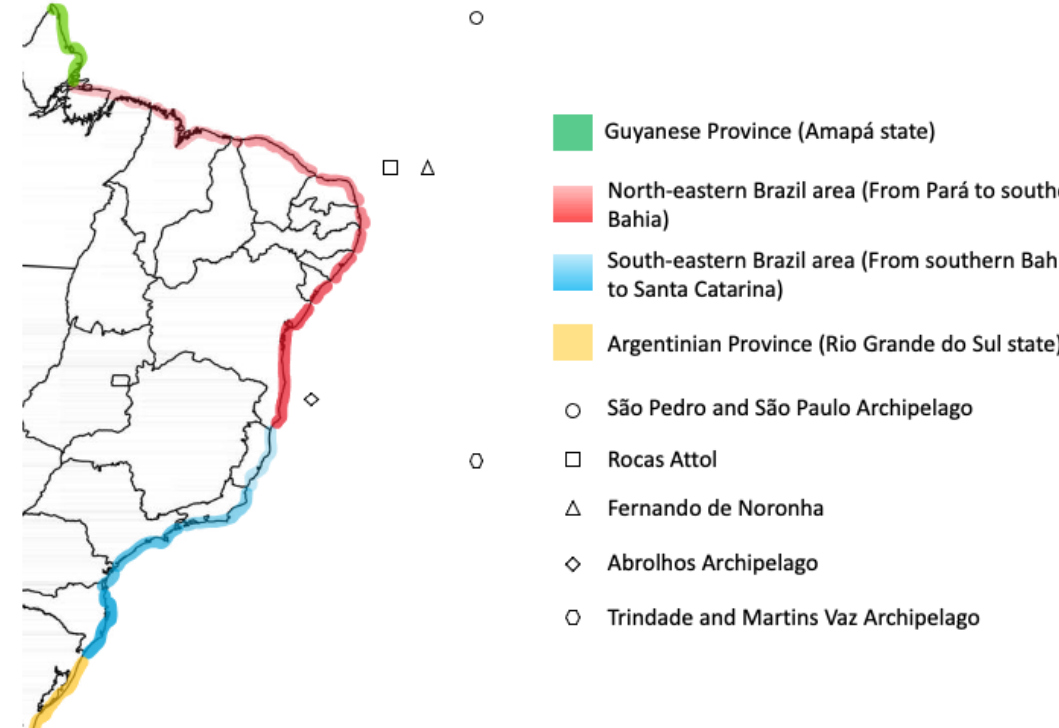
Figure 2. Biogeographical division of the Brazilian coast according to the distribution of marine prosobranch species from shallow waters proposed by Barroso et al.